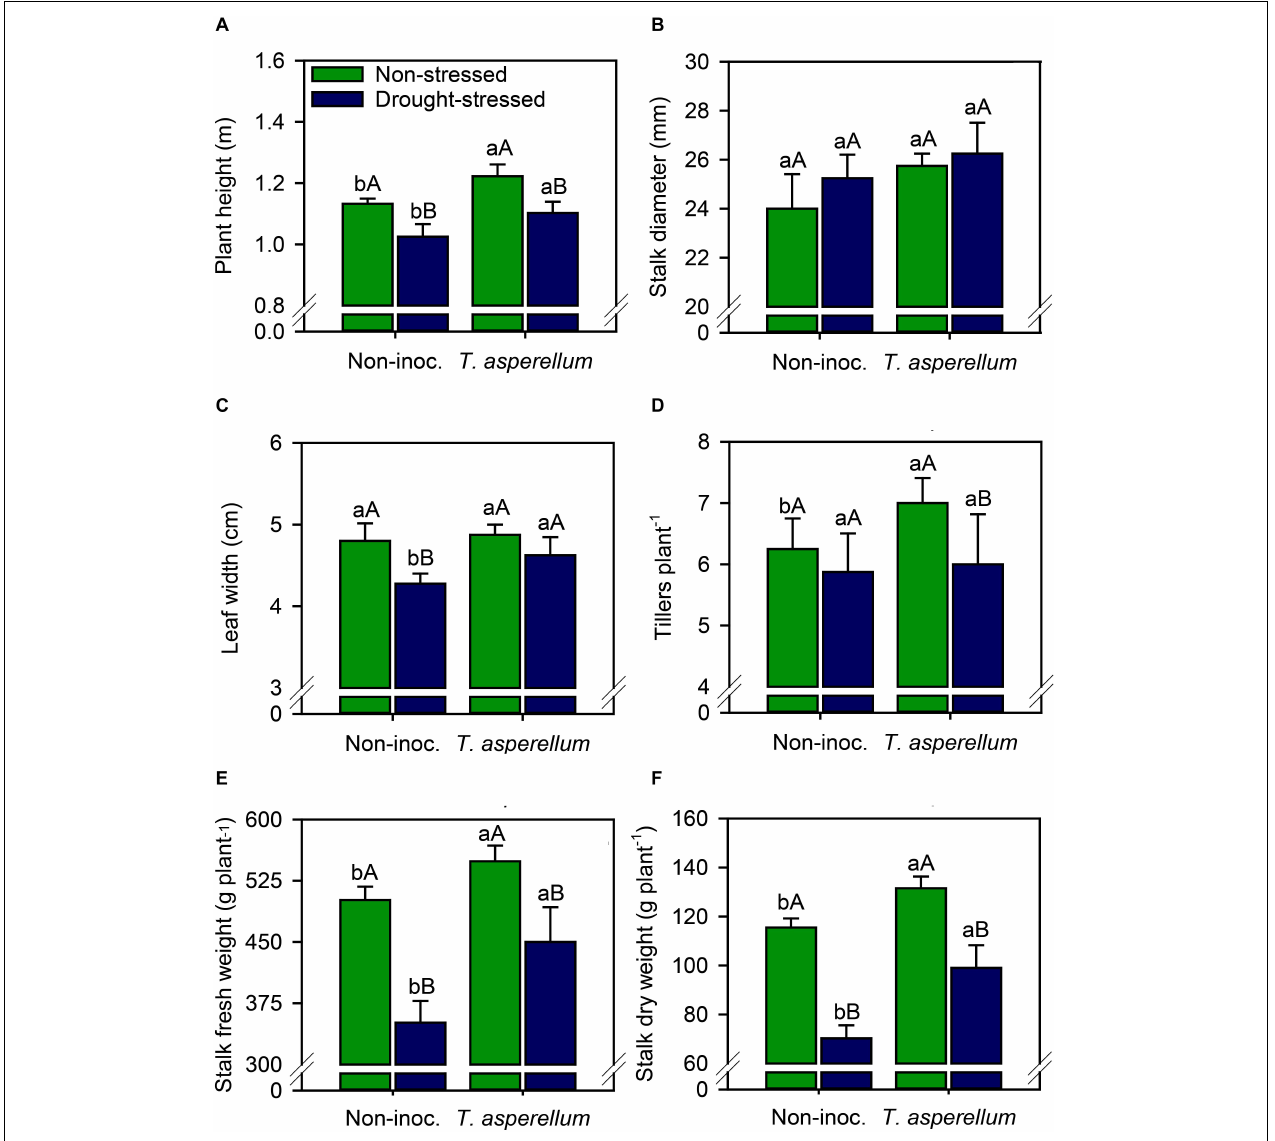
FIGURE 6 | Plant height (A) , stalk diameter (B) , leaf width (C) , tillers plant − 1 (D) , stalk fresh weight (E) , and stalk dry weight (F) of sugarcane plants according to the treatments. Different lowercase letters indicate significant differences between presence and absence of moderate drought stress, and different capital letters indicate significant differences between presence and absence of inoculation with T. asperellum by Fisher’s protected LSD test at p ≤ 0.05. Error bars express the standard error of the mean ( n =